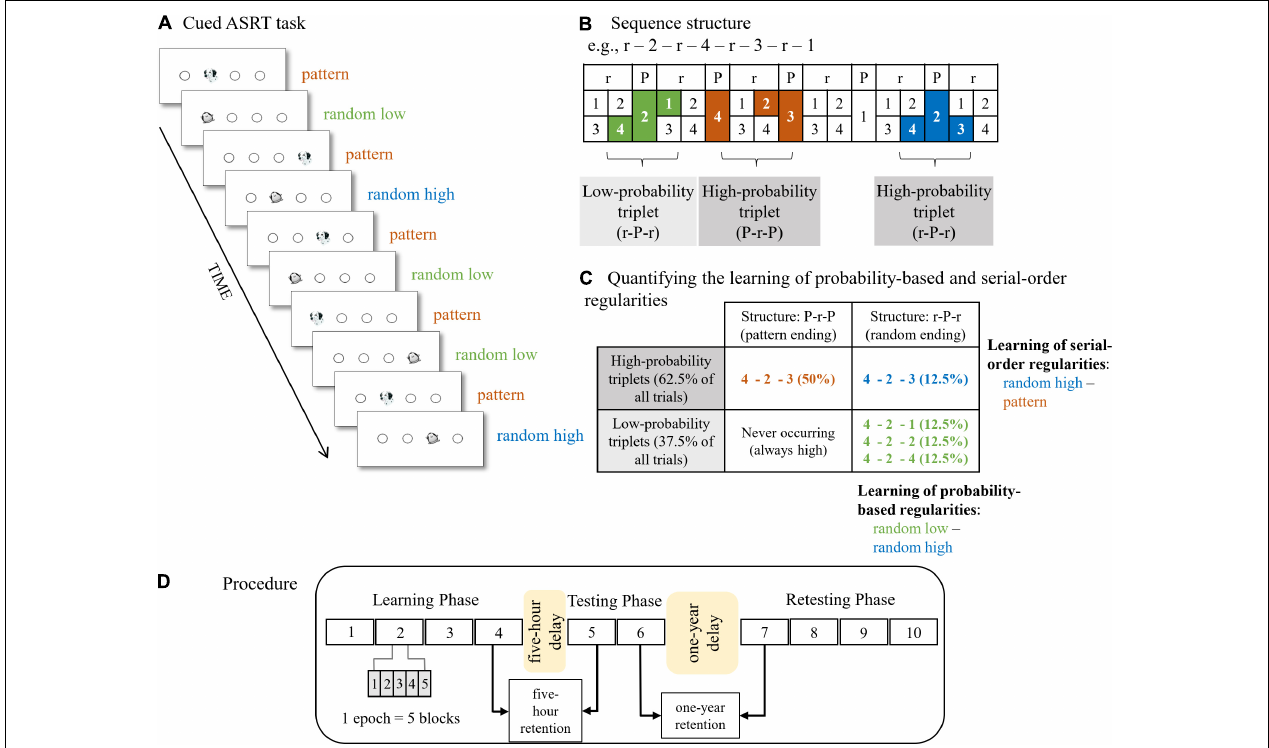
FIGURE 1 | The cued Alternating Serial Reaction Time (ASRT) task and experimental procedure. (A) Pattern and random trials were presented in an alternating fashion. Pattern trials were represented by a dog’s head and random trials were represented by a penguin. (B) An example of the sequence structure. In the example sequence, numbers mark pattern trials and “r” marks a randomly selected location out of the four possible locations. The alternating presentation of trials makes some runs of three consecutive trials (called triplets) more probable than others, labeled as high-probability and low-probability triplets, respectively. High-probability triplets can end either with a pattern or a random trial, whereas low-probability triplets always end with a random trial. Therefore, we can differentiate pattern triplets which are always of high probability (orange shading in panel B and orange font in panel C ), random high-probability triplets (blue shading in panel B and blue font in panel C ), and random low-probability triplets (green shading in panel B and green font in panel C ). (C) Quantifying the underlying learning processes in the task. Learning of probability-based regularities is quantified by contrasting the RTs on the random high and random low trials (blue vs. green, the right column of the table). Learning of serial-order regularities is calculated by contrasting the RTs on the pattern and random high trials (orange vs. blue, the top row of the table). (D) The design of the experiment. The experiment consisted of three sessions. The Learning Phase and Testing Phase were administered on the same day with a 5-hour offline period between them. The Learning Phase was composed of four epochs (one epoch contained 5 blocks, and each block consisted of 85 stimuli) and the Testing Phase was composed of two epochs. The four-epoch-long Retesting Phase was administered ca. 1 year later. Figures 1A–C are adapted from Nemeth et al. (2013) and Zavecz et al. (2020), Figure 1D is adapted from Kóbor et al.